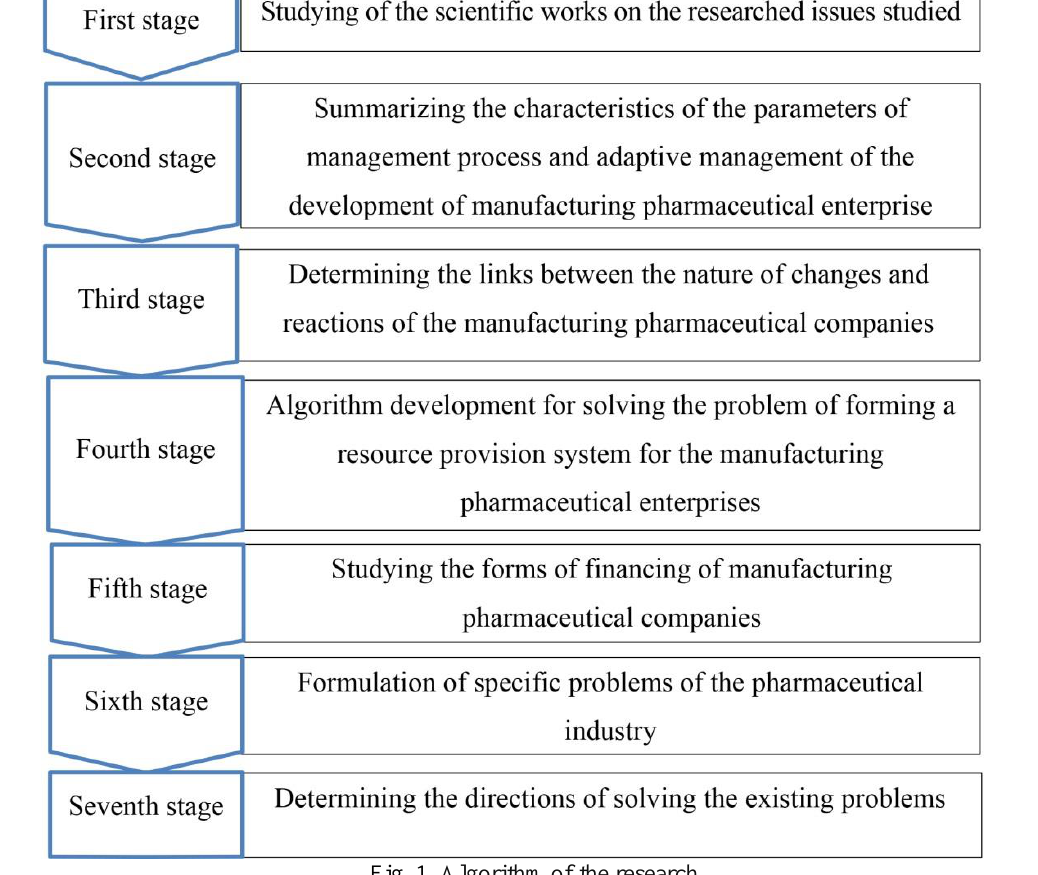
Fig. 1. Algorithm of the